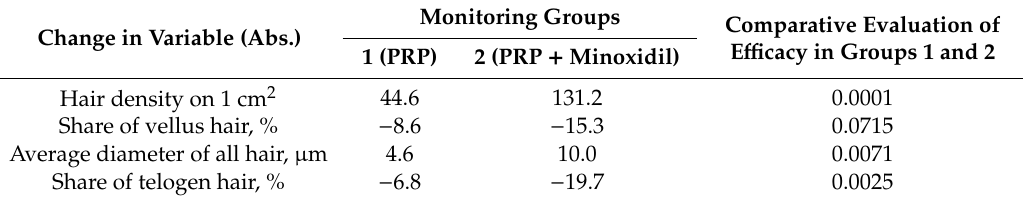
Table 3. Comparison of the e ff ectiveness of treatment in observation groups 1 and 2. Change in Variable (Abs.)